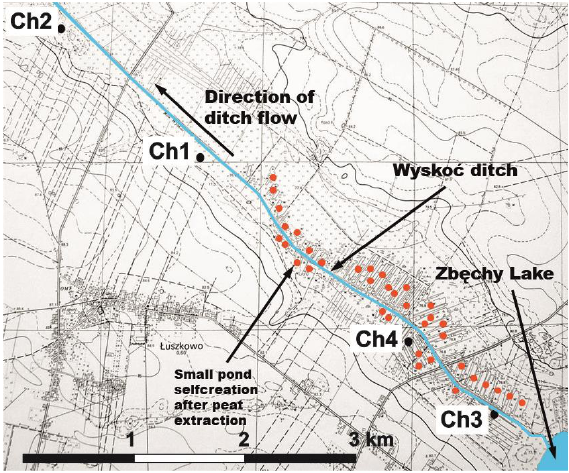
Figure 2. Location of the sites Ch1, Ch2, Ch3, and Ch4 (peat-moorsh soils — Turew).